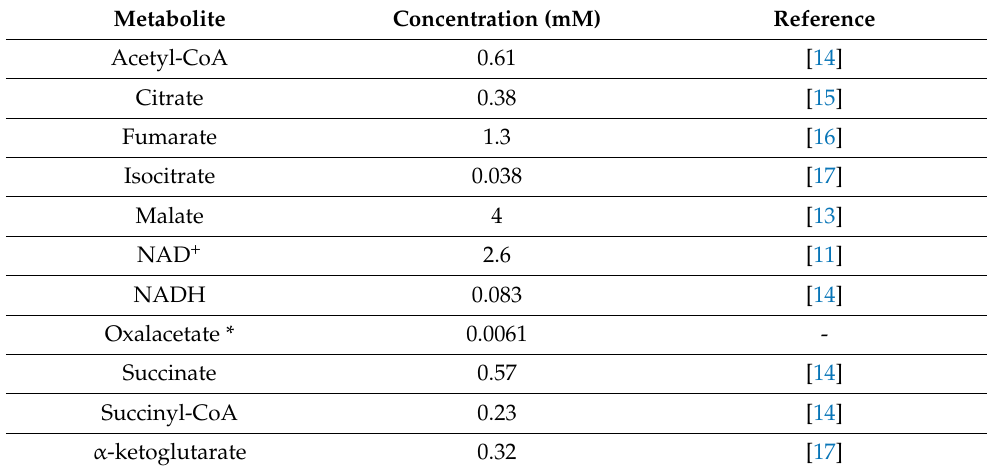
Table 1. Metabolite concentrations (in mM) used to model